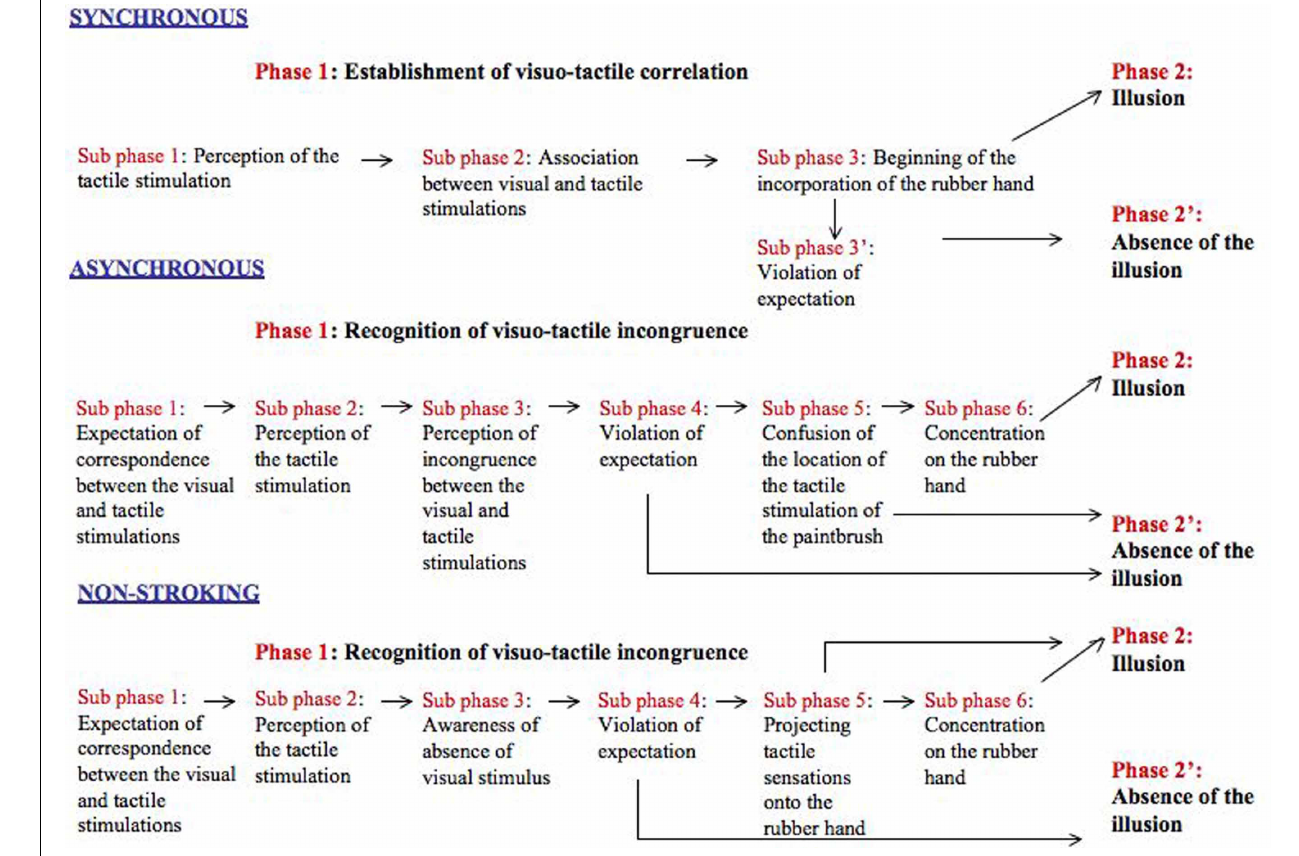
FIGURE 2 | Generic diachronic structure of each visuo-tactile condition. The name of each visuo-tactile condition appears in blue. Black arrows indicate sequential order of the phases and sub phases.